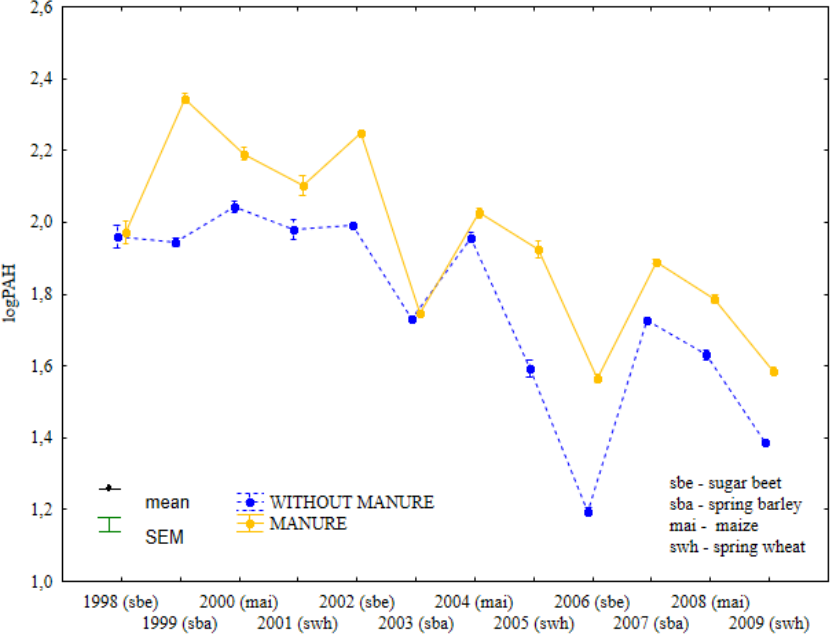
Figure 2. Total content of light PAHs in soil under different crops in treatments supplied with both manure and mineral fertilizers or mineral fertilizers only (log transformed data for 1998–2009). From 2003–2009, similar changes in the content of light PAHs were observed in soil fertilized with manure and mineral fertilizers and in treatments supplied with mineral fertilizers only. The concentrations of light PAHs increased significantly in treatments that were regularly fertilized with manure after spring barley cultivation (1999) and sweet beet cultivation (2002), whereas the content of light PAHs did not change in soil supplied with mineral fertilizers only. Combined manure and mineral fertilization, and mineral fertili- zation only exerted opposite effects on the total content of light PAHs in soil samples col- lected after maize cultivation in 2000. 3.2. Total Content of Heavy PAHs Maize was least effective in reducing the concentrations of heavy PAHs in soil (Fig- ure 3, Table S3). In contrast, spring wheat grown after maize decreased heavy PAH levels in soil in all years of cultivation. Sweet beets exerted a less adverse effect on the content of heavy PAHs in soil than maize.